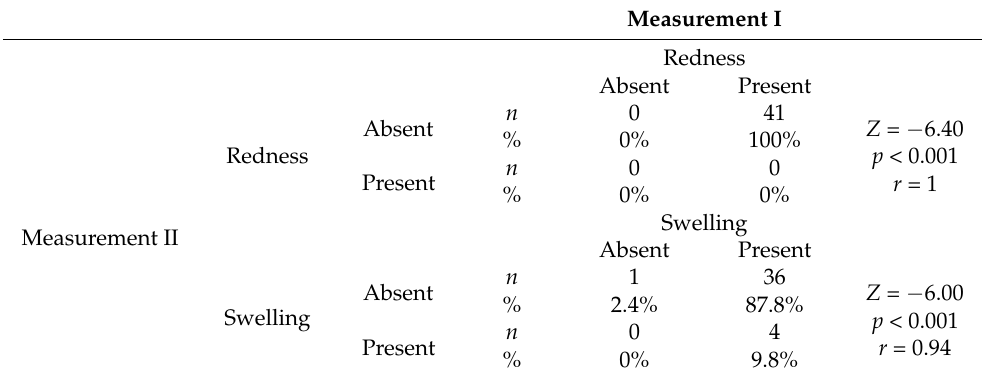
Table 3. Redness and swelling before (measurement I) and after treatment (measurement II) with a bioactive healing abutment containing clindamycin.